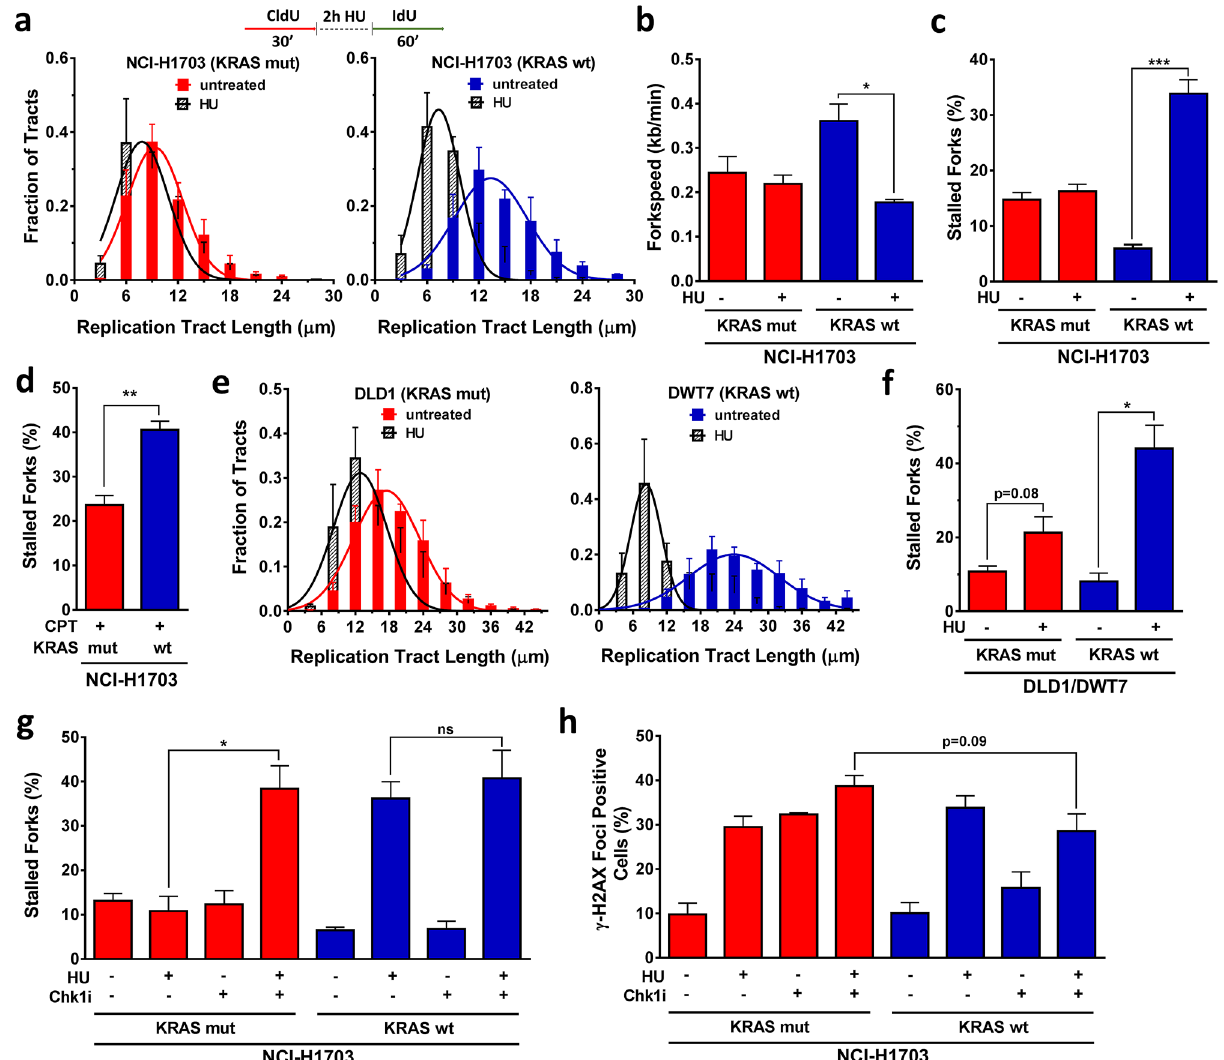
Figure 3. Resistance of KRAS mutant (mut) but not wild-type (wt) cancer cells to hydroxyurea (HU). ( a ) Distribution of fiber length in the isogenic NCI-H1703 pair with and without HU treatment (2 mM) administered for 2 h in between pulse labels. ( b ) Velocity of fork progression with and without HU treatment. ( c, d ) Percentage of fibers indicating fork stalling with/without 2 h treatment with HU or the topoisomerase I inhibitor camptothecin (CPT). ( e, f ) Distribution of fiber length and percentage of fork stalling in isogenic DLD1/DWT7 cells, analogous to panels A and B. ( g, h ) Combined effects of treatment with HU and CHK1 inhibitor (Chk1i) LY2603618 on fork stalling or γ-H2AX foci formation. All bars represent mean + /- SEM based on at least 3 independent repeats. Statistical comparisons by two-sided T-test indicating * p ≤ 0.05, ** p ≤ 0.01, *** p ≤ 0.001; ns, not